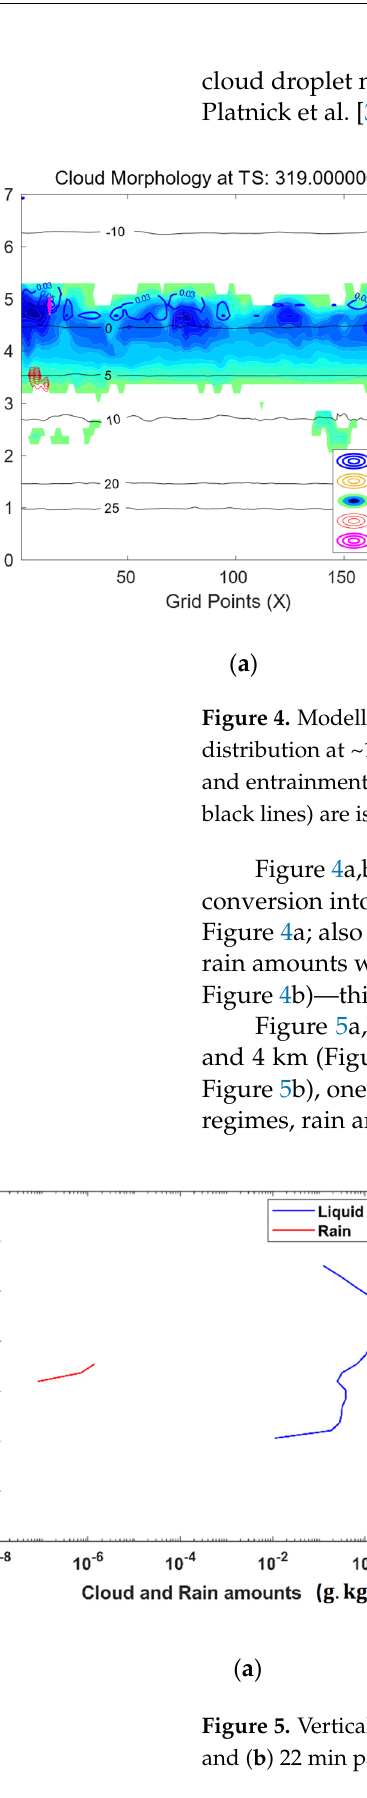
Figure 3 that the time taken for m (cid:2868) ~ 1.5 gm (cid:2879)(cid:2871) to decrease to m (cid:2868) /e ~ 0.55 gm (cid:2879)(cid:2871) was indeed 232 ~ 17 min .